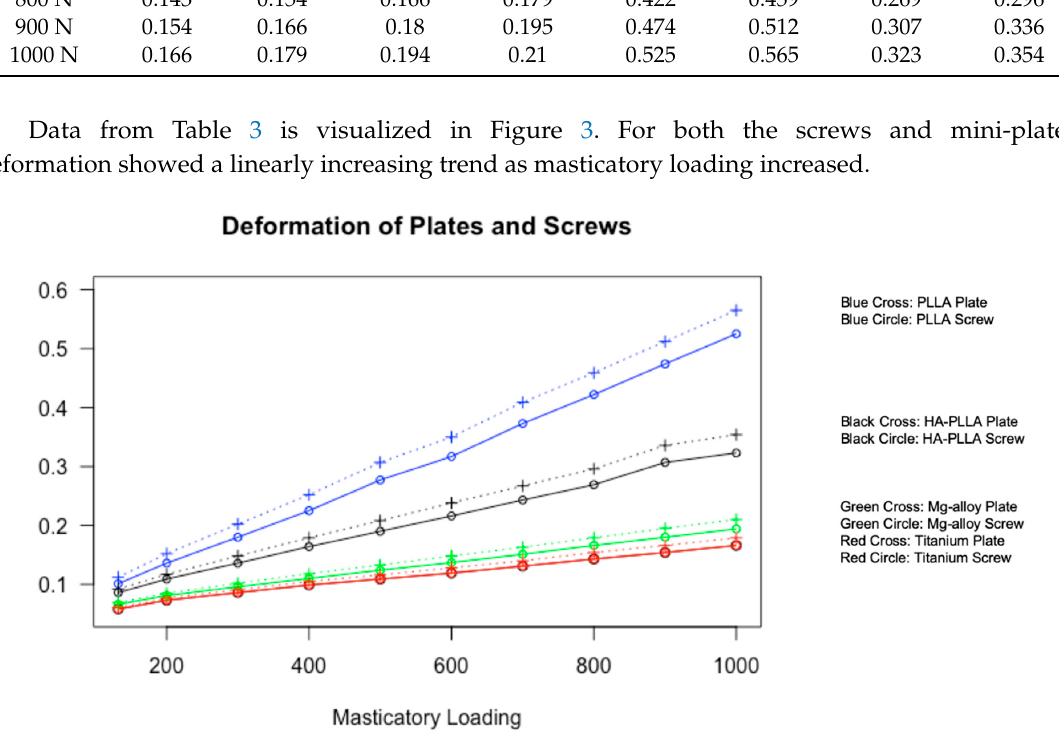
Figure 3. Visualization of material deformation against masticatory loading. All four materials show a linearly increasing trend of deformation for both screws and plates with different slopes. Titanium shows the least deformation, whereas PLLA shows the most deformation at the same pressure.